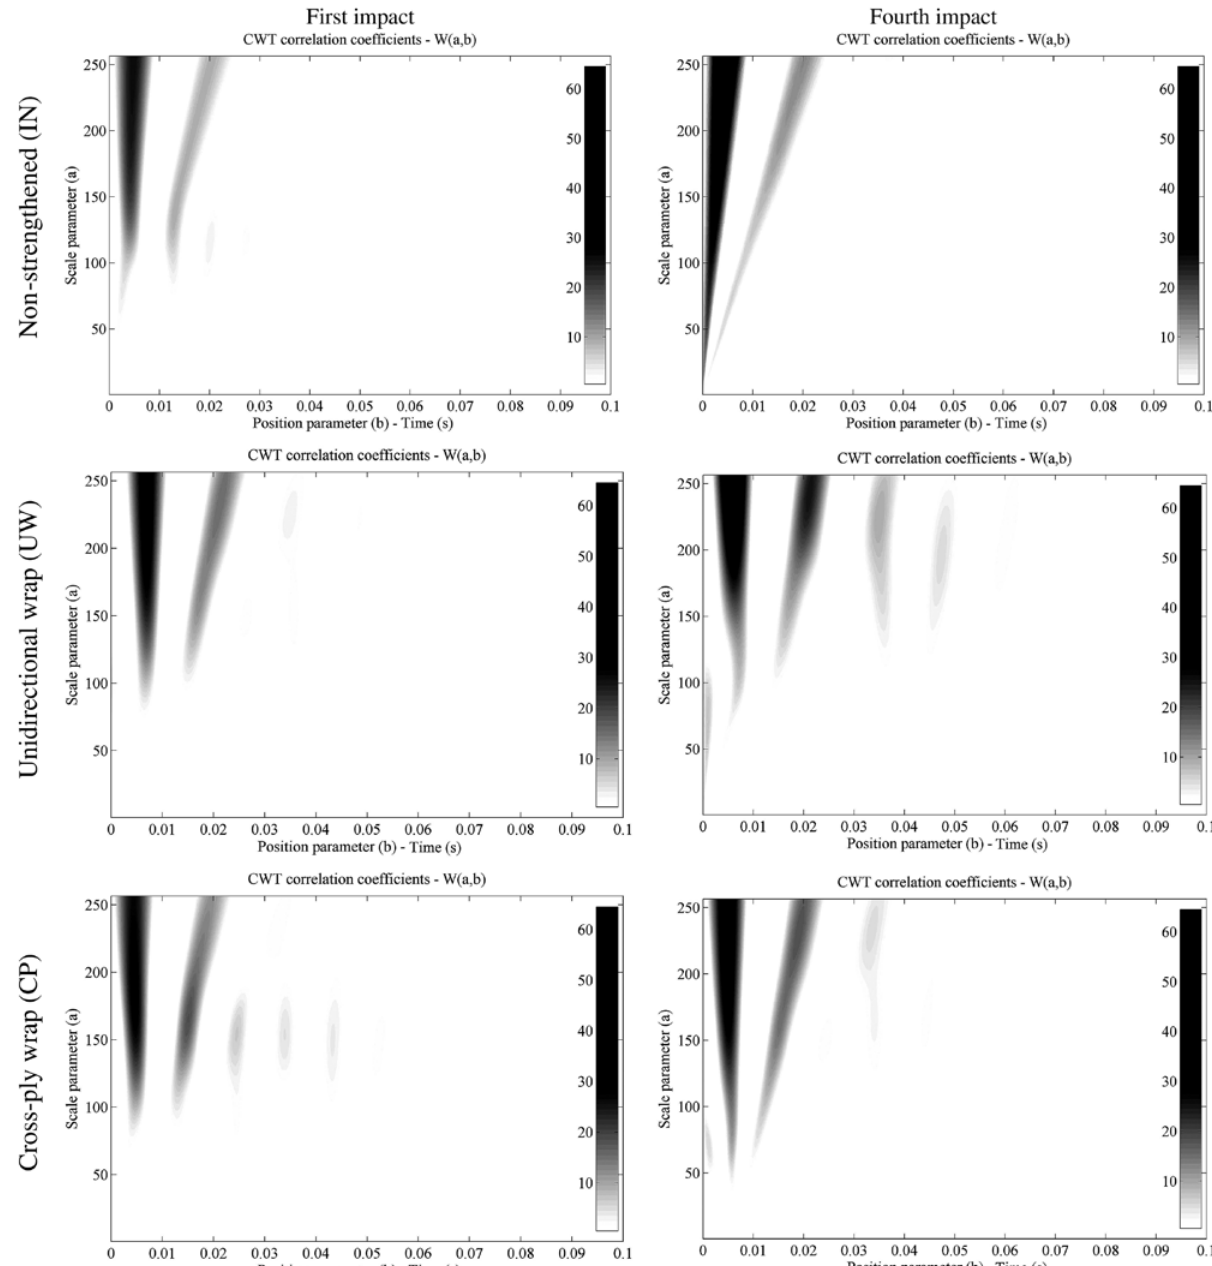
Figure 7: CWT coefficient distribution for deflection